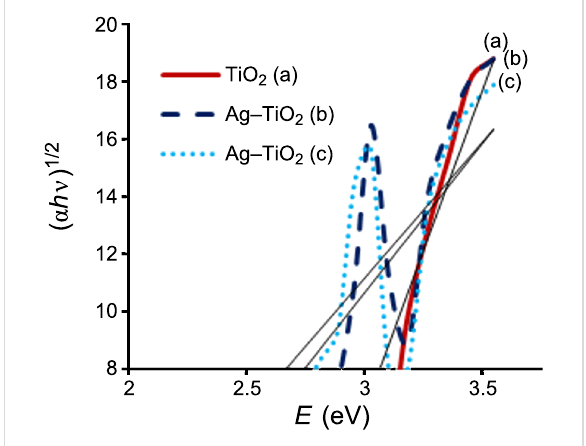
Figure 4: Band gap obtained by extrapolating the linear portion of the ( α h ν ) 1/2 versus photon energy (eV) curve of (a) TiO 2 and (b) 3% and (c) 7% Ag-doped TiO 2 nanoparticles.